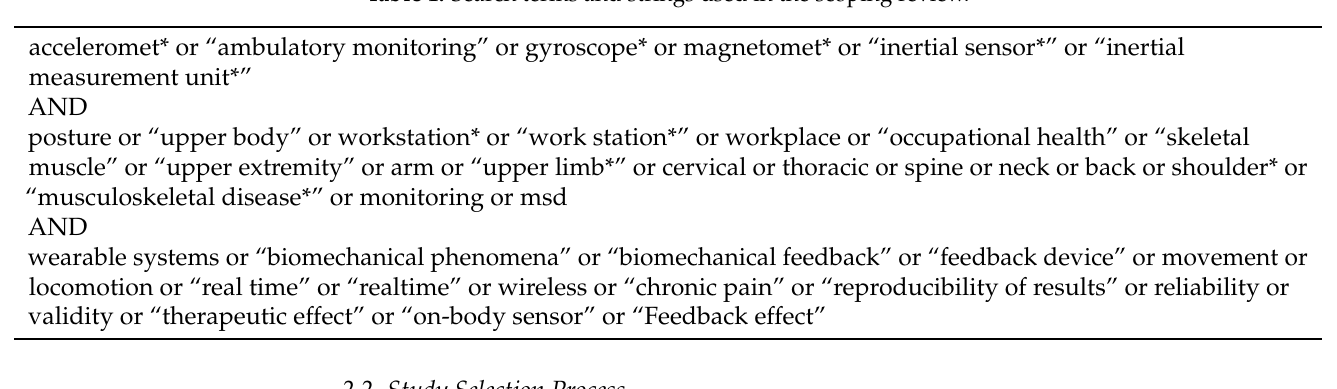
Table 1. Search terms and strings used in the scoping